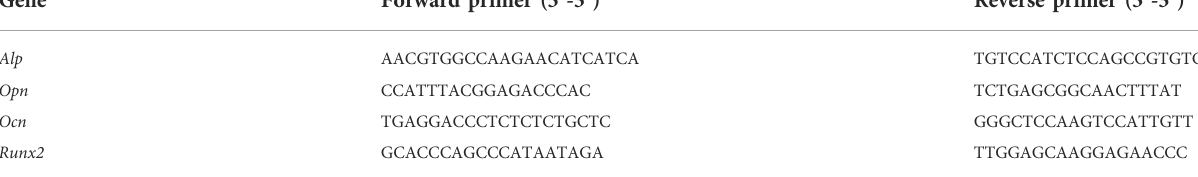
TABLE 1 Nucleotide sequences of primers used for RT -PCR.